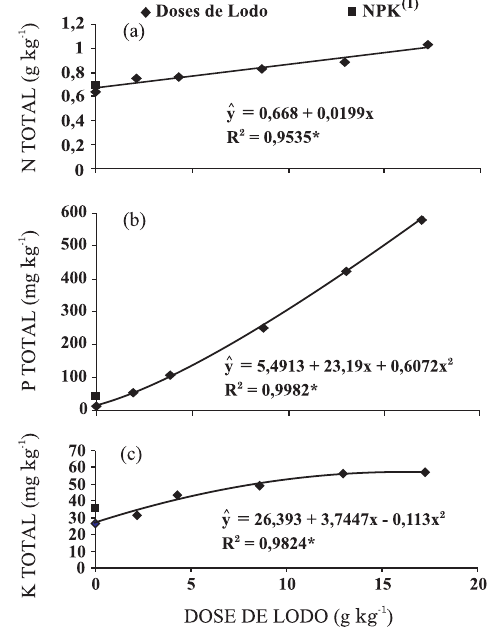
Figura 3. Variação dos teores de nitrogênio (a), fósforo (b) e potássio (c) total no solo após a aplicação do lodo anaeróbio da estação de tratamento de efluentes de parboilização de arroz. (1) Tratamento NPK incluído como referência fora da análise de